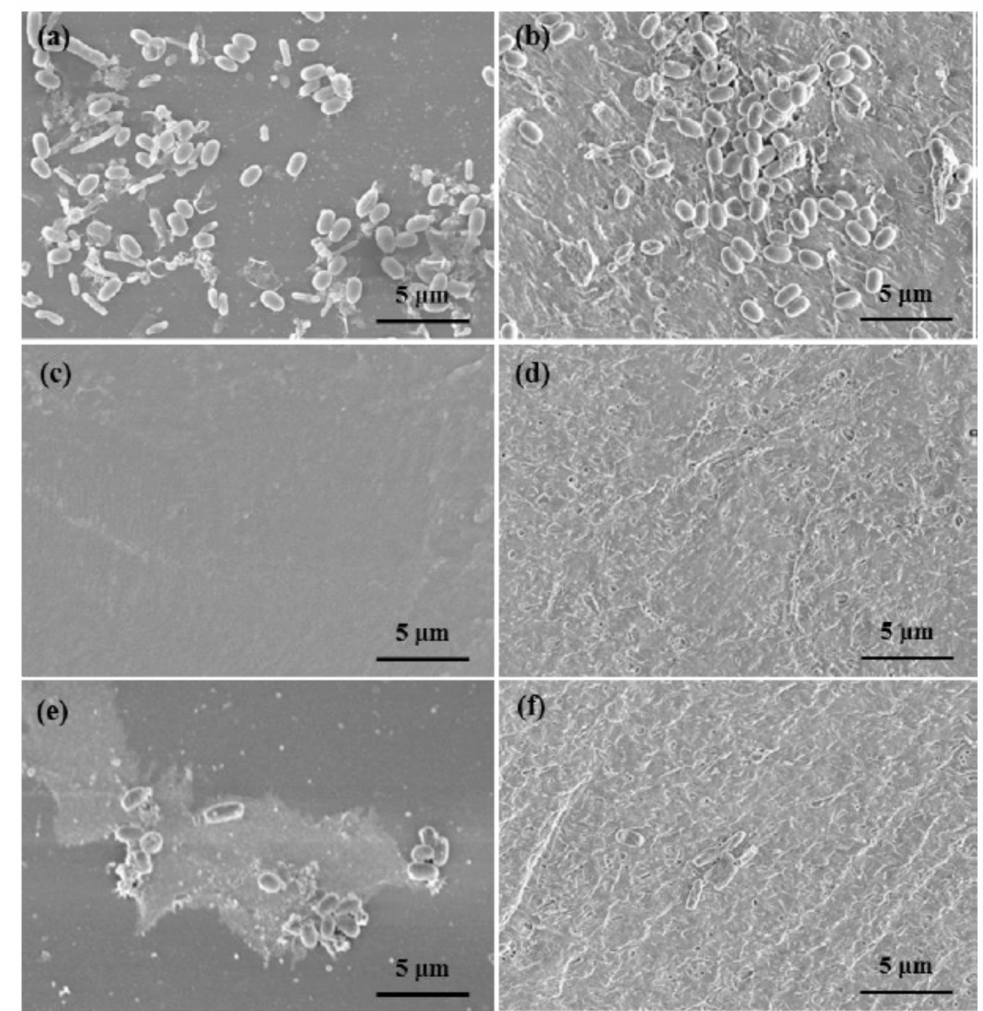
Figure 15. SEM images of the bacteria on the coating surface (left column—epoxy resin; right column— epoxy-halloysite formulations): ( a ) pure epoxy resin; ( c , e ) epoxy resin directly doped with DCOIT; ( b ) epoxy resin composited with pristine/empty halloysite; ( d , f ) epoxy resin with DCOIT-loaded halloysite. The samples were incubated in Vibrio natriegens suspension for three days ( c , d ) and after exposure to seawater for 60 days on a shaking platform. Figure derived from the work of Fu et al.